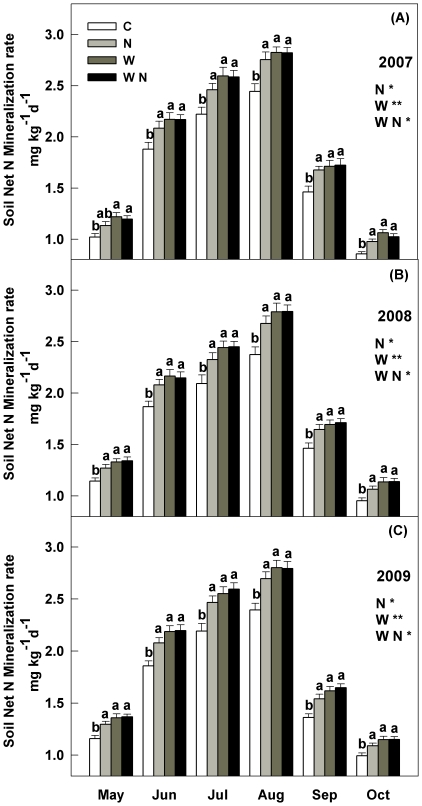
Seasonal dynamics of soil net N mineralization rate (NMR) at 15 cm depth under warming (1.8°C) and N addition (10 g m−2 yr−1) treatments in temperate grassland of northeastern China.Values show the monthly means of soil NMR from May to October in three years. Vertical bars indicate standard errors of means (n = 6). Difference lowercase letters indicate statistically significant differences (P<0.05). *, ** represent significant at P<0.05 and P<0.01. See Figure 1 for abbreviations.